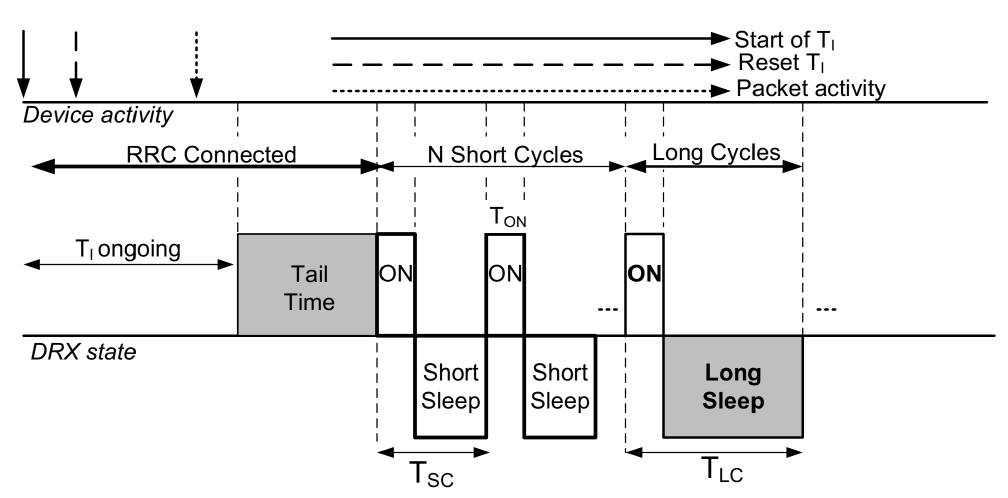
Figure 1. An overview of the discontinuous reception (DRX) mechanism in LTE-A.